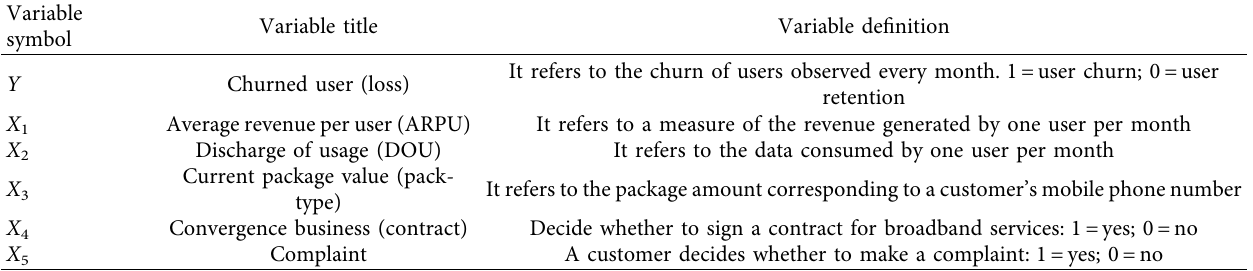
Table 1: Variable interpretation.